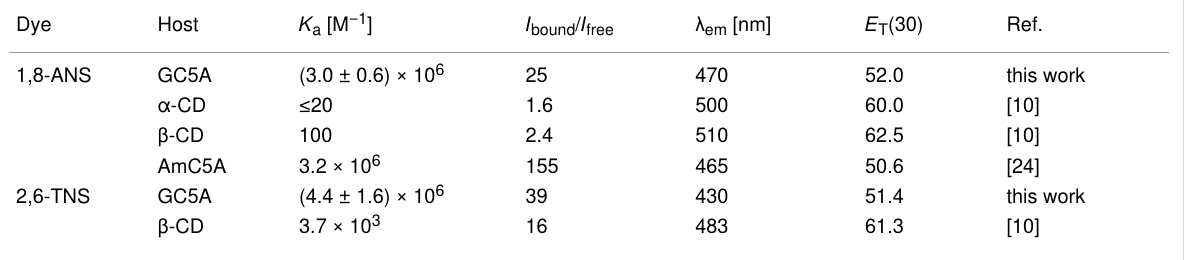
Table 2: Binding constants and photophysical properties of host–guest complexes and the calculated polarities of macrocyclic hosts. Dye Host K a [M − 1